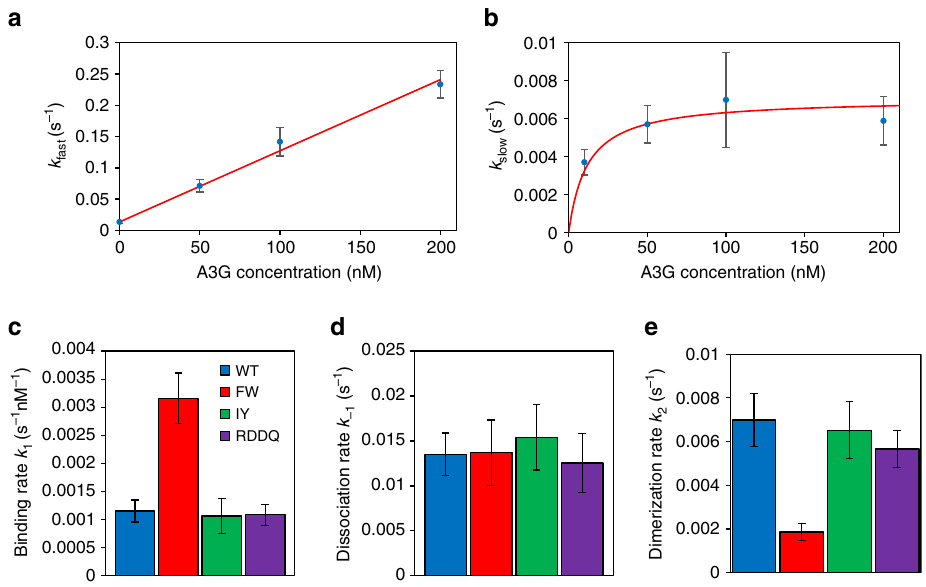
Fig. 4 Measured rates of binding and oligomerization of A3G on ssDNA. a , b fast and slow binding rates for WT as a function of concentration. The data point 0 nM is the average single exponential rate fi t to dissociation curves (Fig. 3b). All other data points are the average fast ( a ) and slow ( b ) exponential rates fi t to incubation curves at varying WT A3G concentrations. The expected behavior of k fast and k slow are plotted ( red lines ) based of the derived values of k 1 , k − 1 and k 2 . k fast is linear with concentration and k slow saturates at high concentrations ( ck 1 ≫ k − 1 ). c – e Concentration independent, bimolecular binding rate k 1 , unbinding rate k − 1 , and rate of oligomerization k 2 for WT A3G and mutants. The NTD mutant (FW) binds to ssDNA at an increased rate but forms oligomers much more slowly than the WT and CTD mutants. All error bars are SEM based on at least three independent experiments and resulting fi tting parameters per